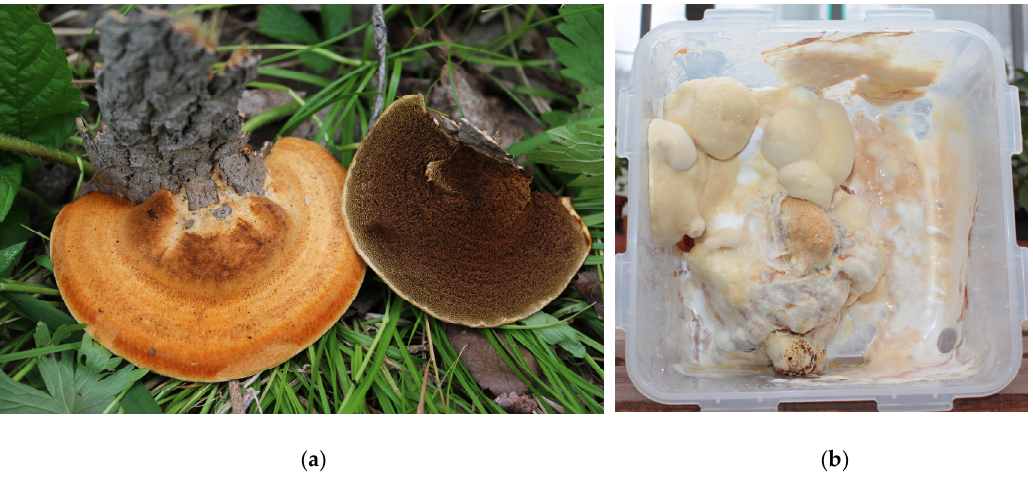
Figure 1. Fruit bodies of Inonotus rheades (Pers.) Karst. (fox polypore) in its natural habitat (Kadinskii reserve, Kuitun District, Irkutsk Oblast, Russia) ( a ) and lab-grown I. rheades mycelium ( b ). The diverse range of chemical components found in I. rheades includes styrylpy- rones and bis(styrylpyrones), in particular 1,1-distyrylpyrylethane, trans - and cis -hispidin, trans - and cis -bisnoryangonin, phellinins A1 and A2, hypholomine A, 3-bisnoryangonyl- 14 (cid:48) -hispidin, hypholomine B, 3,14 (cid:48) -bishispidinyl, rheadinin [7,8], triterpenes as